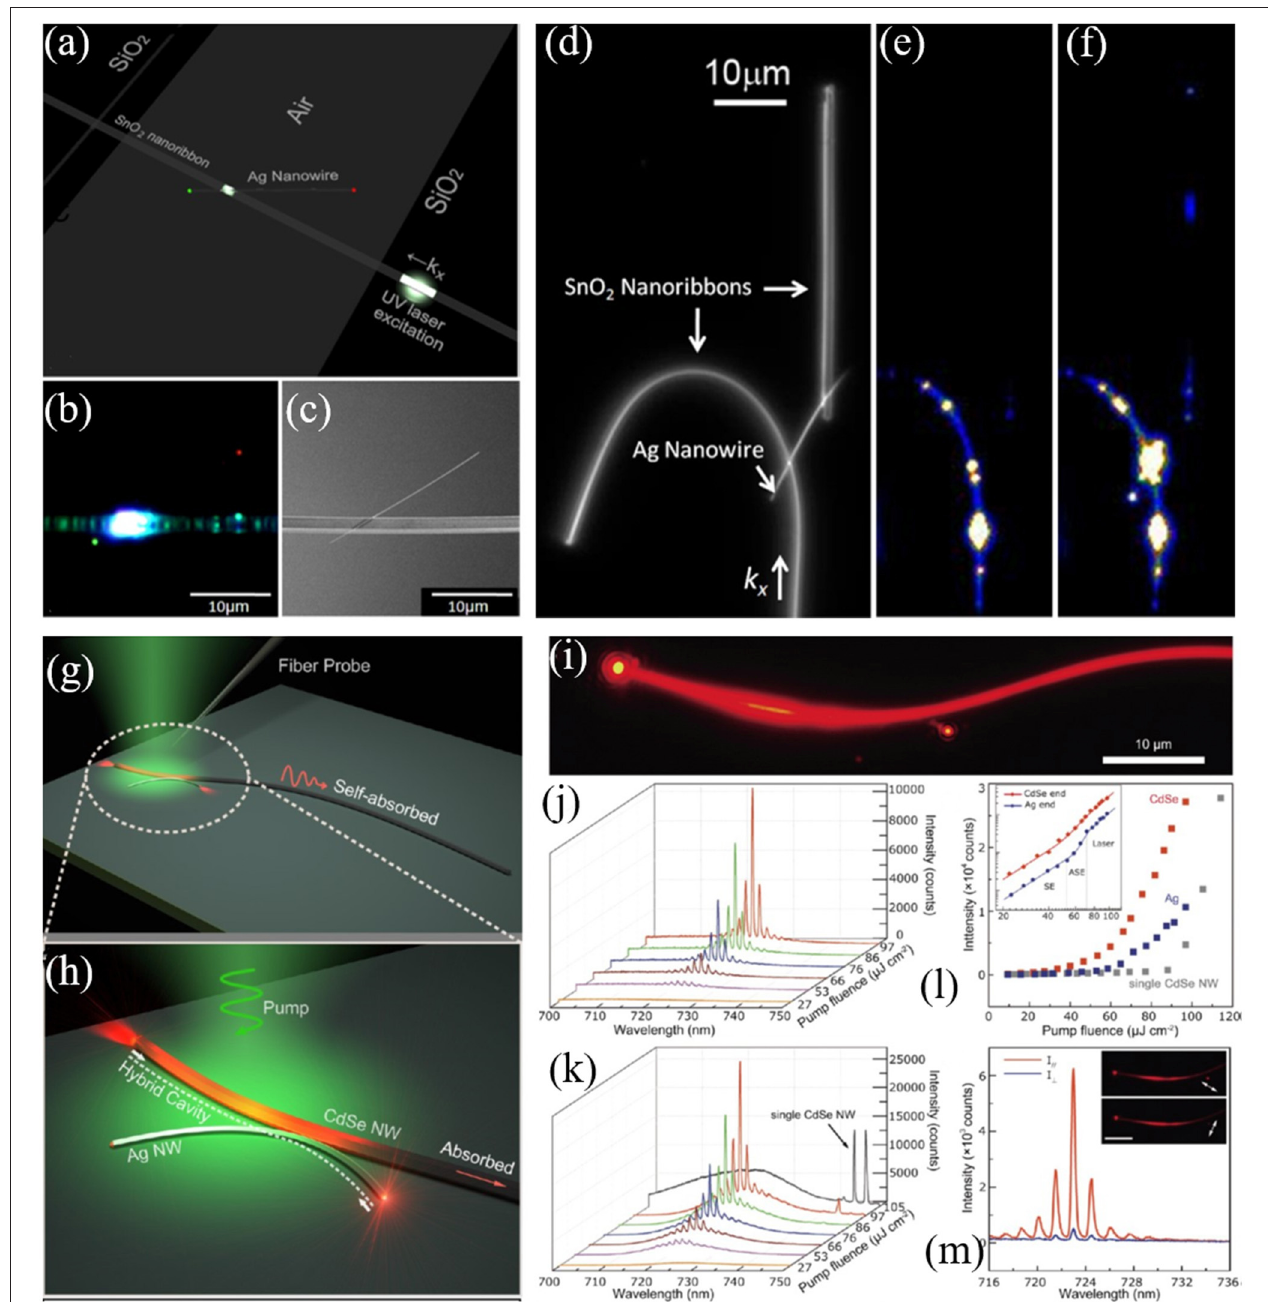
FIGURE 6 | (a) Schematic representation of the photonic-plasmonic routing device. (b) Optical microscope image of the SnO 2 waveguiding and routing. Scale bar: 10 µ m. (c) SEM image of the device. Scale bar: 10 µ m. (d) Dark field optical image of the SnO 2 /Ag/SnO 2 coupling device. Scale bar: 10 µ m. Optical image when the PL of the bent SnO 2 nanoribbon was excited from the bottom end with (e) and without (f) the bridging Ag nanowire. (g) Schematic of the hybrid photon-plasmon nanowire laser. (h) Closed-up view of the coupling area. (i) Optical microscope image of the hybrid structure under pumping intensity 97 µ J cm − 2 . Scale bar: 10 µ m. Lasing spectra collected from the Ag (j) and CdSe (k) end-facet under pump fluences of 27–97 µ J cm − 2 . (l) Emission intensity vs. pump fluence collected from end-facets of the CdSe nanowire (red squares) and the Ag nanowire (blue squares). The gray-square pattern is from the single CdSe nanowire without coupled Ag nanowire. Insets show the log-log scale relation between emission intensity vs. pump fluence. (m) Polarization-sensitive lasing spectra from Ag nanowire end-facet with the emission polarization oriented parallel (red line) and perpendicular (blue line) to the Ag nanowire. Inset: dark-field microscope images show the polarization-dependent lasing outputs. Scale bar: 10 µ m. (a–f) Reproduced with permission. Yan et al. (2009) Copyright 2009, National Academy of Sciences. (g–m) Reproduced with permission. Wu et al. (2013) Copyright 2013, American Chemical Society.